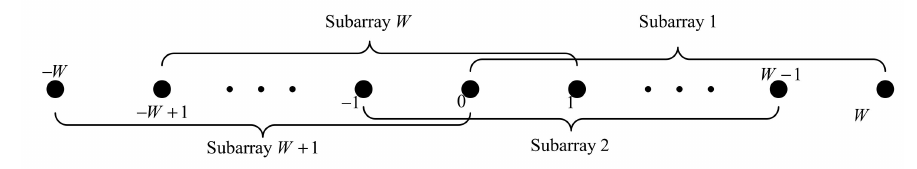
Figure 3. The process of spatial